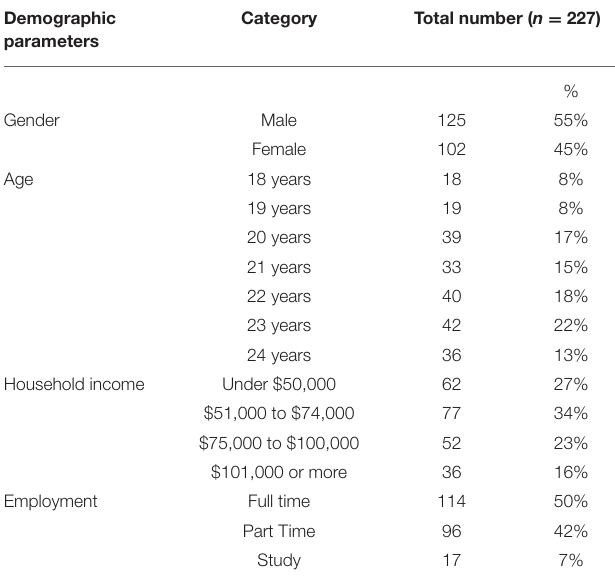
TABLE 1 | Demographic characteristics of Sydney Gen Z